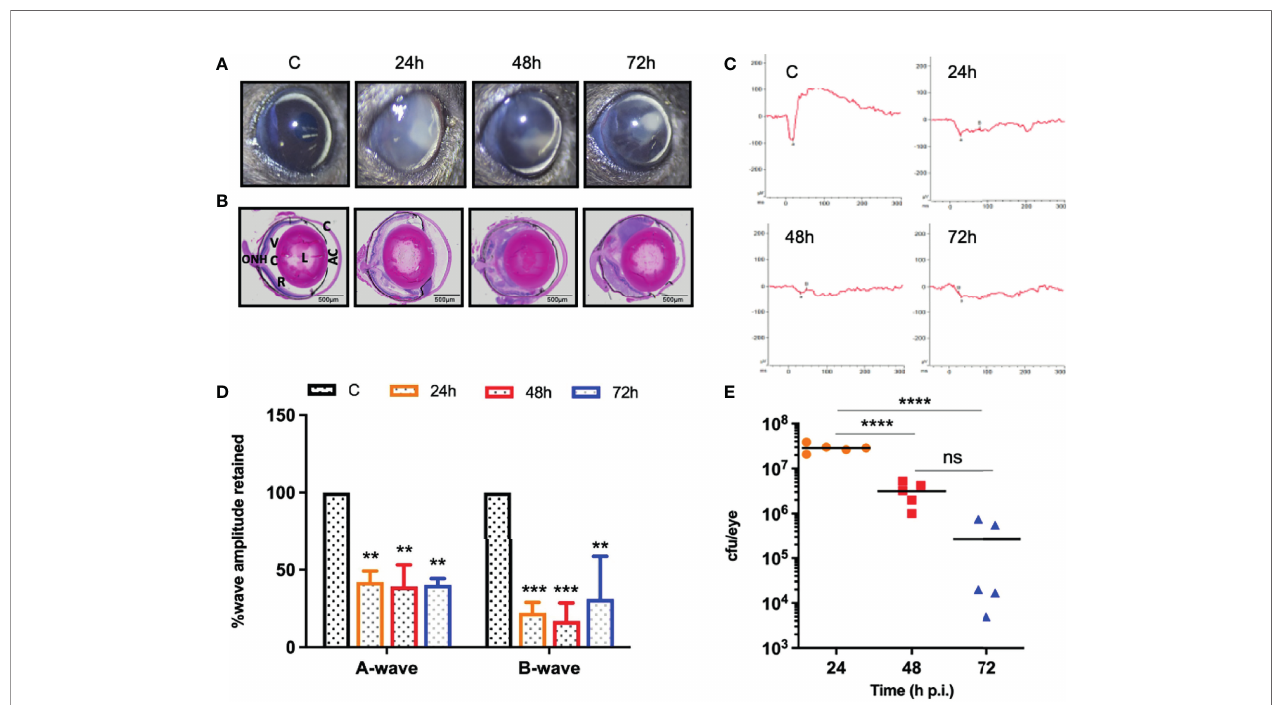
FIGURE 2 | S. epidermidis induces retinal tissue damage in the eye. C57BL/6 mice eyes (n = 5 eyes at each time point) were given intravitreal injections of 10 7 cfu/eye of S. epidermidis or PBS (control, C), and eyes were processed at indicated times post-infection. Eyes with PBS injection harvested at 72 h p.i. were used as control. (A) Slit-lamp examination was performed, and photomicrographs were taken from representative eyes to visualize corneal haze/opacity. (B) At indicated time points post-infection, eyes were enucleated, paraf fi n fi xed, and stained with H&E. (C) Scotopic electroretinogram (ERG) analysis was performed to assess retinal function. (D) Bar graph showing percent a- and b-wave amplitude retained with respect to control (C) eyes set at 100%. (E) At indicated time points, eyes were enucleated and homogenized, and the bacterial burden was estimated via serial dilution plating. C, cornea; AC, anterior chamber; L, lens; VC, vitreous chamber; R, retina; ONH, optic nerve head. Statistical analysis was performed using ANOVA with Dunnett ’ s multiple comparison test (D) or Tukey ’ s multiple comparison test (E) , (**) p<0.01 (***) p<0.001 (****) p<0.0001; ns, nonsigni fi